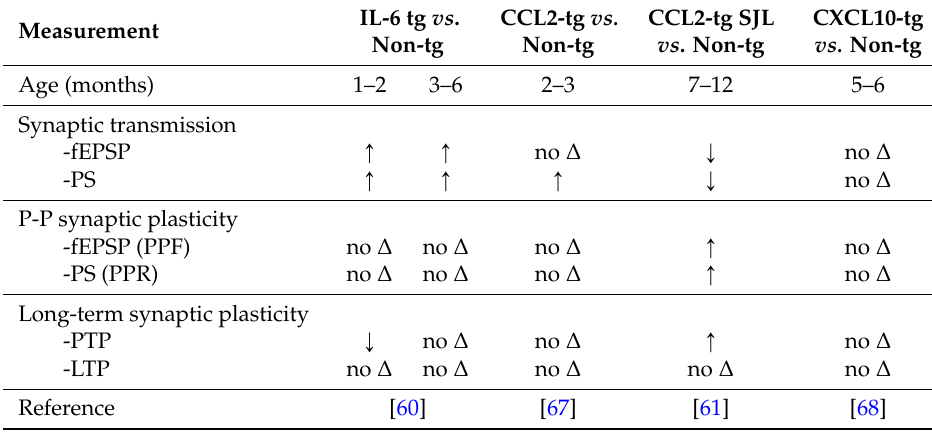
Table 1. Genotypic differences in synaptic function in the